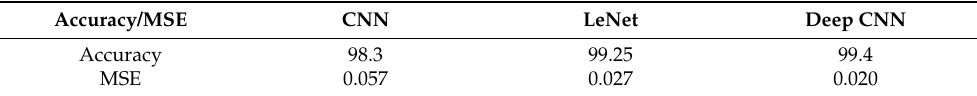
Table 2. Accuracy and Loss Comparison of CNN, LeNet, and Deep CNN Models on the Pashto Character